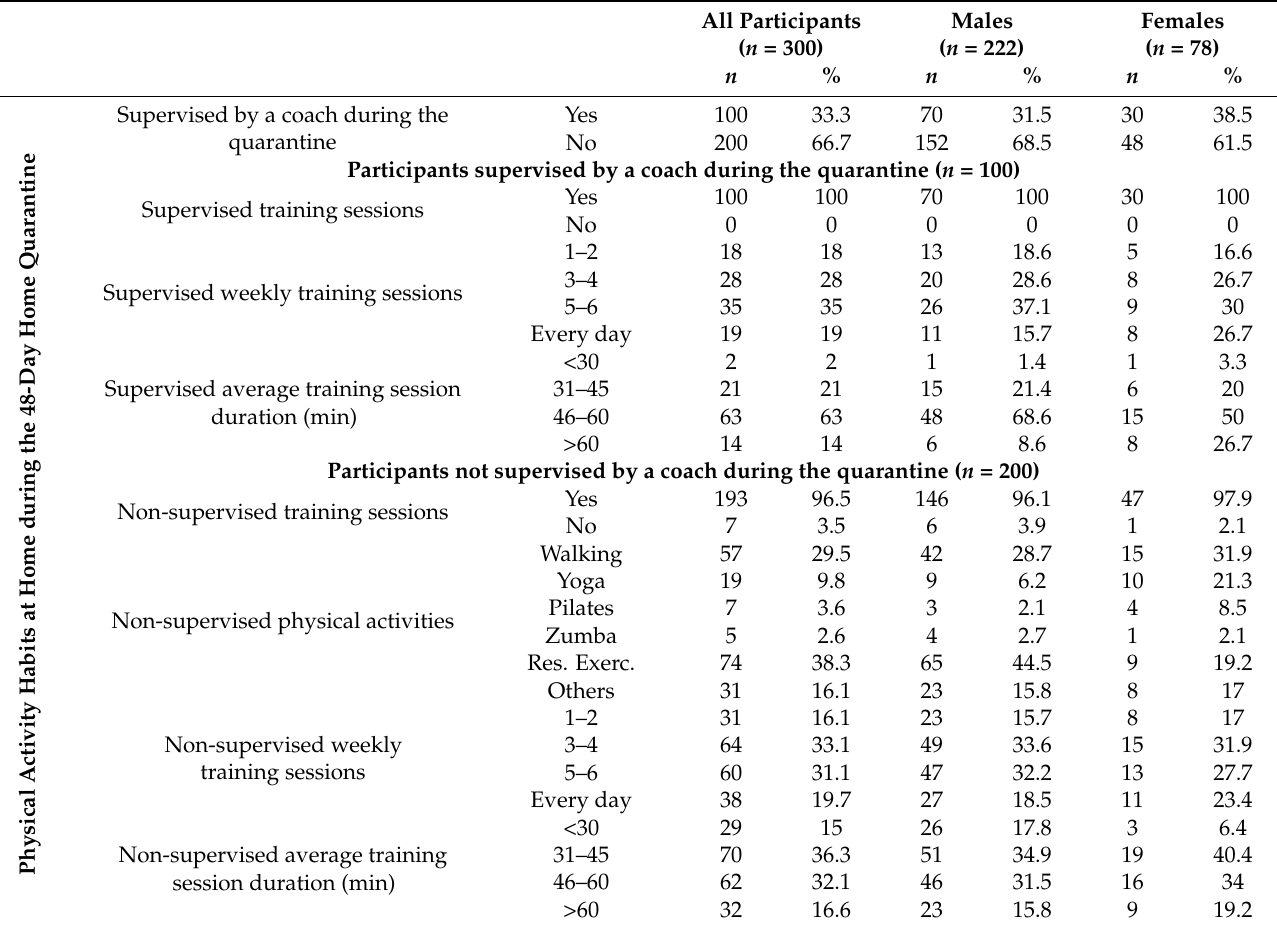
Table 2. Physical activity habits at home during the 48-day home quarantine of recreational runners in